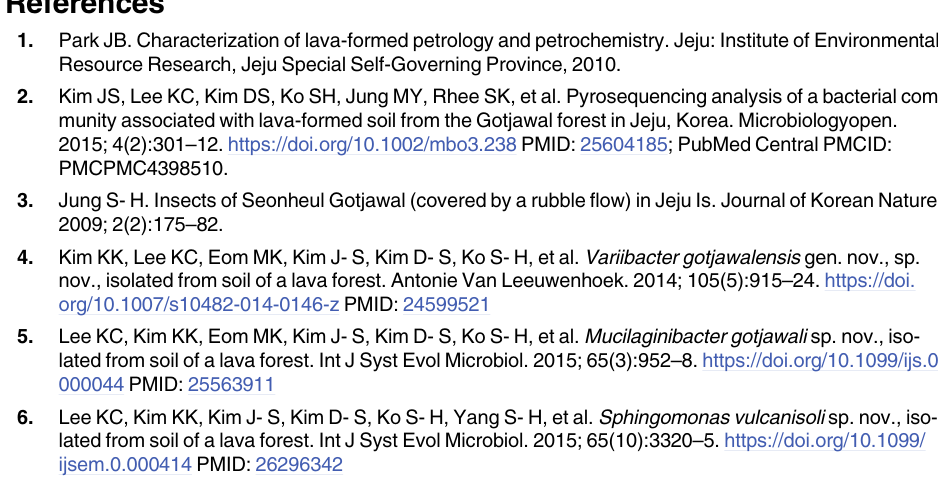
S7 Fig. Rarefaction curves of Chao1 index with 16S rRNA sequence reads from MiSeq with 20 Gotjawal forest samples. S8 Fig. Bacterial composition at the phylum level. S1 Table. The geographic coordinates of the soil samples collection sites. S2 Table. Geological features and vegetation in Gotjawal. S3 Table. Community richness and diversity of Gotjawal soils. S4 Table. Relative mean abundance of the phylogenetic groups presents in the Gotjawal